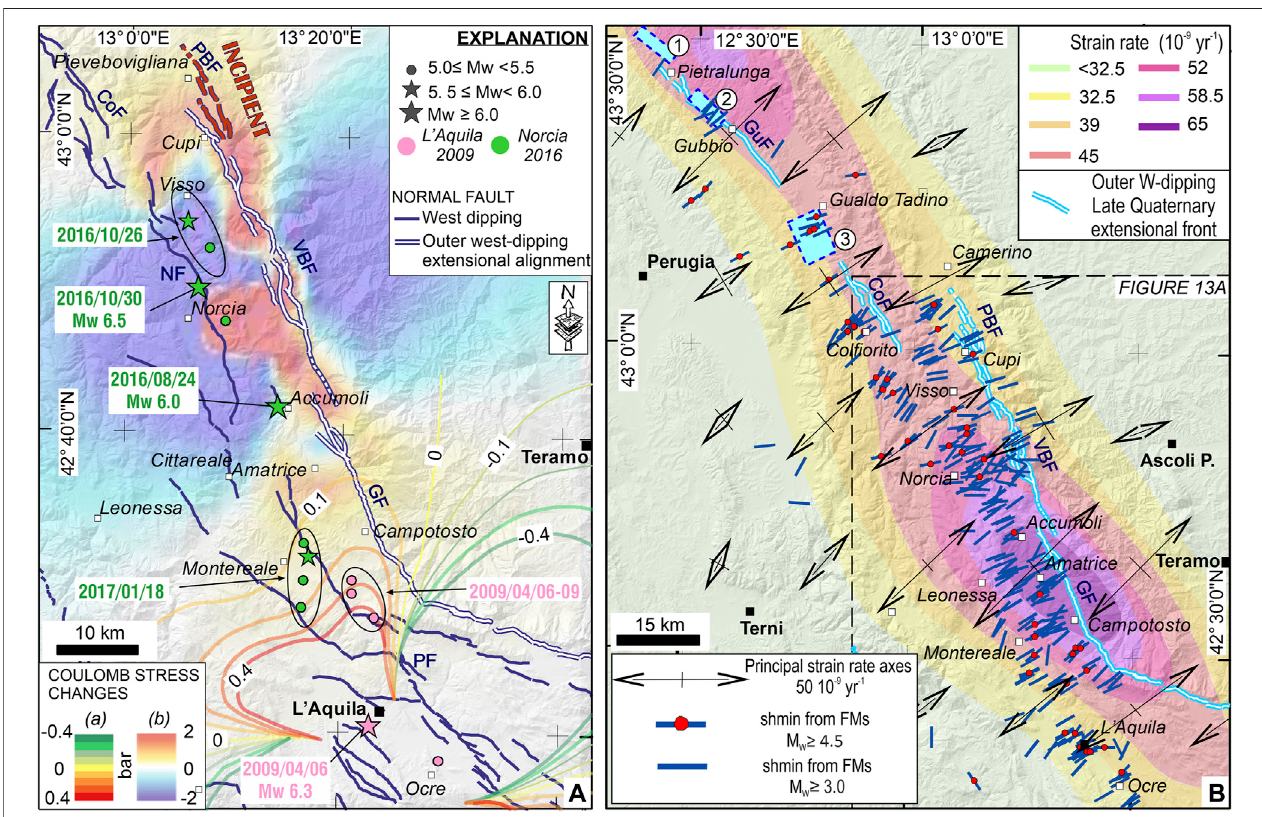
FIGURE13| Tectonicsketchmapanddeformation fi eldincentralItalyshowingthenewlyproposedPievebovigliana(incipient)faultalongtheouterW-dippingLate Quaternary extensional front. (A) Tectonic sketch map reporting the Pievebovigliana (incipient) fault along the northward extent of the outer extensional alignment in the locusoftheNorcia2016andL ’ Aquila2009seismicsequences.Theevents(M ≥ 5.0,fromISIDeWorkinggroup(2007))relatedtothemainseismicsequencesstrikingthe sector (i.e., the L ’ Aquila 2009 and Norcia 2016) are reported and compared with the distribution of the positive Coulomb stress changes as redrawn from (a) Falcucci et al., 2011 (see text for details) and computed in (b) this study ( Figure 11 ). (B) Deformation fi eld observable in central Italy and showing the velocity fi eld from GPSdata (black arrows) and the geodetic strain rate values as redrawn from Barani et al. (2017). In the map are also reported the Shmin (blue bars) trajectories from the focal mechanisms (FMs) ofevents (depth 12 km, M W ≥ 3.0) occurred from 1981 to2018 reported in RCMT (Pondrelli et al., 2006) and TDMT (Scognamiglio et al., 2006). Fault key: CoF (cid:1) Col fi orito fault; GF (cid:1) Gorzano fault; GuF (cid:1) Gubbio fault; PBF (cid:1) Pievebovigliana fault; VBF (cid:1) Mt Vettore-Mt Bove